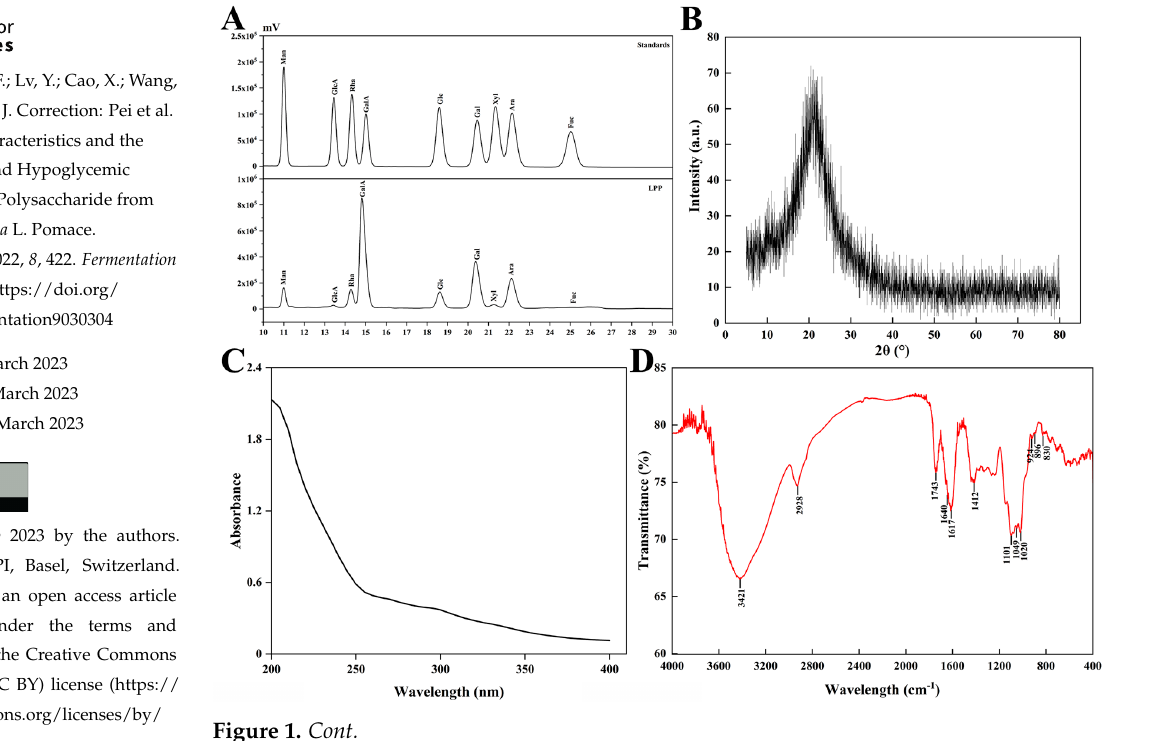
Figure 1. ( A ) Monosaccharide composition, ( B ) XRD, ( C ) UV-vis spectra, ( D ) FT-IR spec- troscopy, ( E ) Gongo red experiment, ( F ) β -Elimination reaction of Lonicera caerulea L. pomace polysaccharide LPP. Reference 1. Pei, F.; Lv, Y.; Cao, X.; Wang, X.; Ren, Y.; Ge, J. Structural Characteristics and the Antioxidant and Hypoglycemic Activities of a Polysaccharide from Lonicera caerulea L. Pomace. Fermentation 2022 , 8 , 422. h tt ps://doi.org/10.3390/fermentation8090422 Disclaimer/Publisher’s Note: The statements, opinions and data contained in all publications are solely those of the individual au- thor(s) and contributor(s) and not of MDPI and/or the editor(s). MDPI and/or the editor(s) disclaim responsibility for any injury to people or property resulting from any ideas, methods, instructions or products referred to in the content.